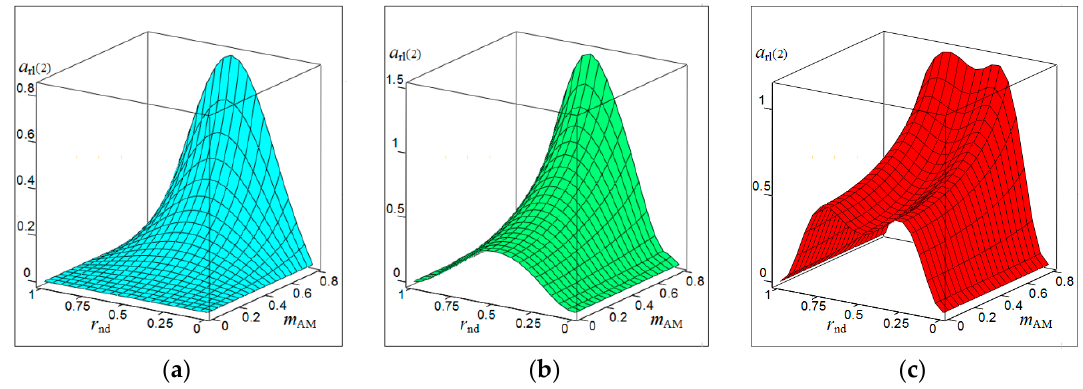
Figure 2. CAS a rl ( 1 ) of the autodyne signal on the variation of the oscillation amplitude with AFM on the first harmonic of the modulation frequency calculated for di ff erent values of k FM : ( a ) k FM = 0, ( b ) k FM = 0.5, and ( c ) k FM = 1.